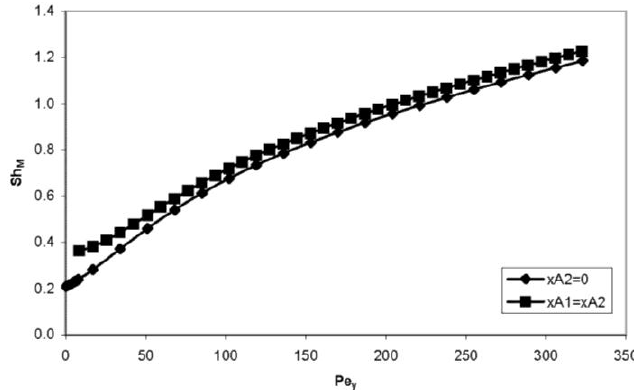
Figure 7. Dependence of the Sh M (Pe y ) function on the asymmetry of the boundary conditions. B/D = 1; H/D = 0.1; limit current; x A1 = x A2 for the upper curve and x A2 = 0 for the lower one.